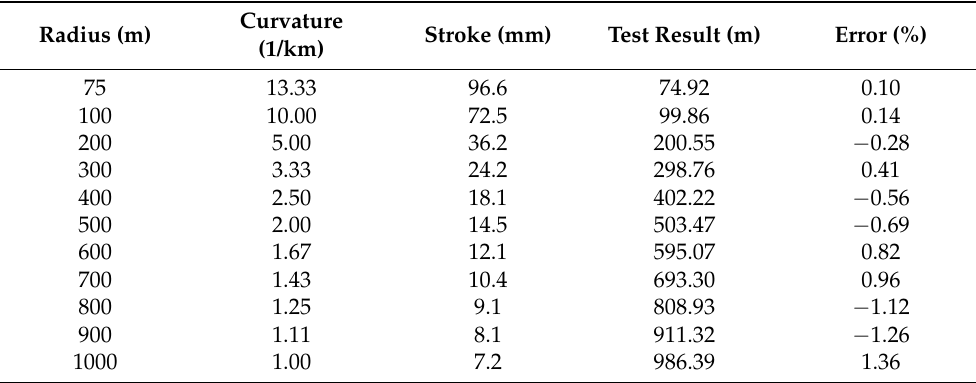
Table 3. Functional test result for the curvature